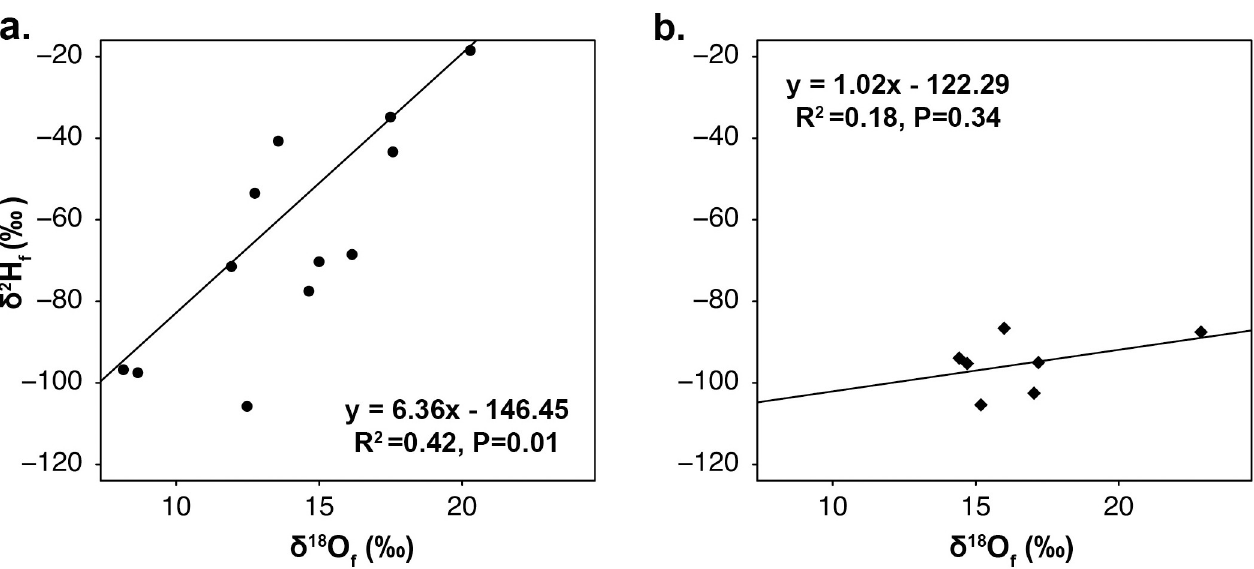
Fig 4. Relationships between the stable isotope compositions of feathers from birds sampled along the migratory flyways. Stable oxygen ( δ 18 O F ‰) and hydrogen ( δ 2 H F ‰) isotope composition of feathers for juvenile migratory Sharp-shinned Hawk ( Accipiter striatus ) specimens collected (a) along the Pacific Coast Flyway at the migratory banding site the Golden Gate Raptor Observatory (GGRO, n = 14) and (b) along the Intermountain Flyway at the migratory banding site Goshute Mountains HawkWatch (Goshutes, n =